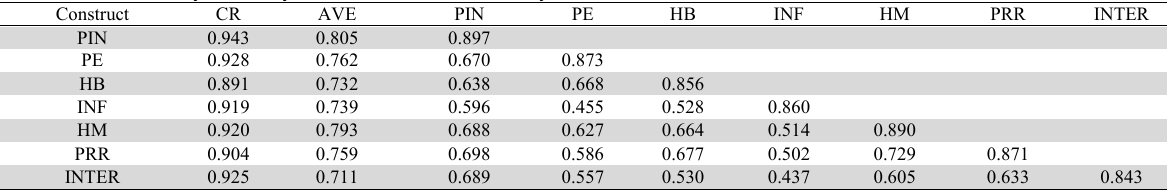
Constructs Reliability, Validity, and Discriminate